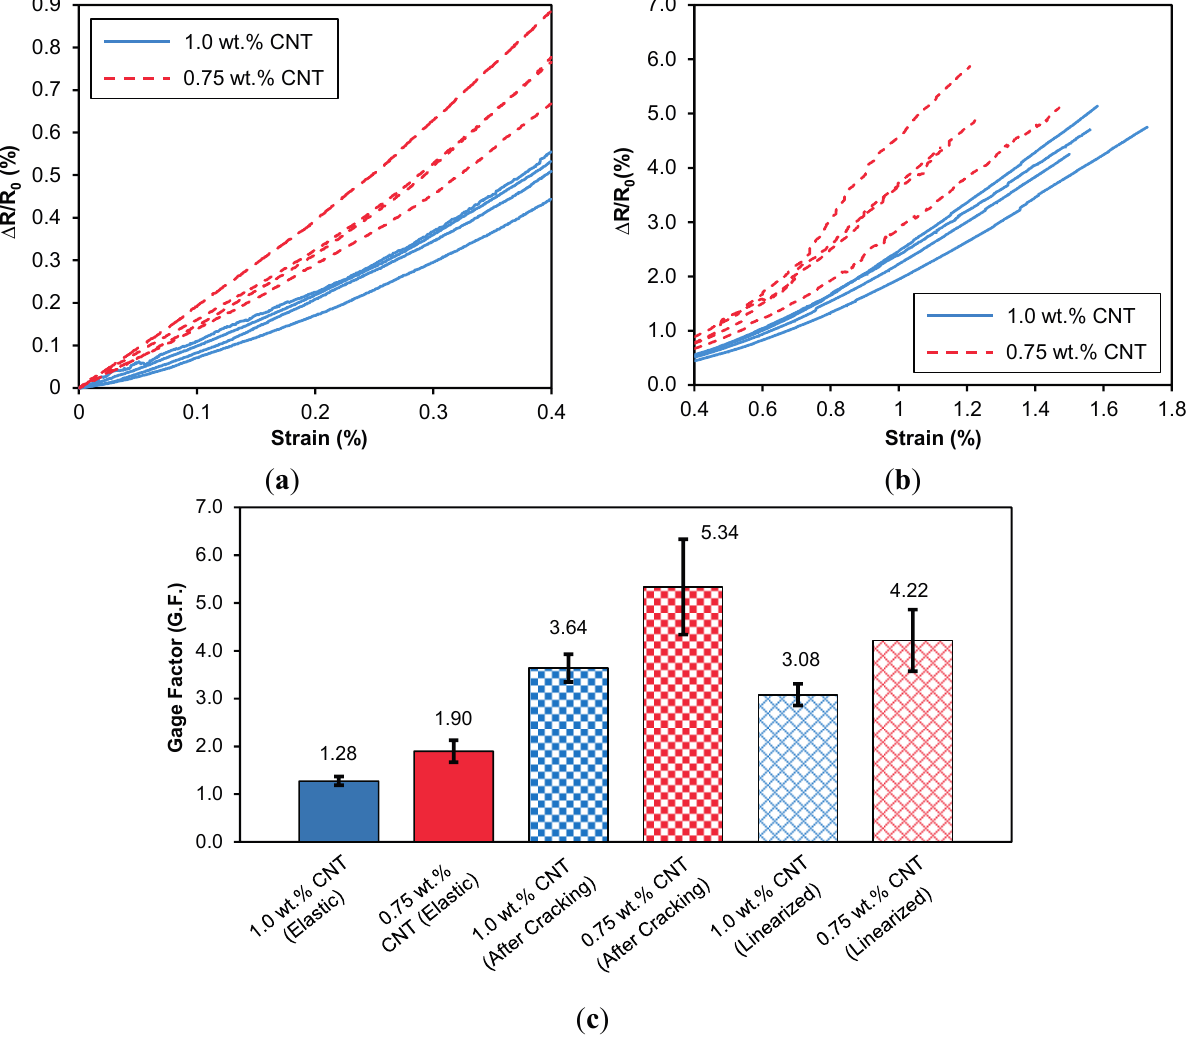
Figure 9. ( a ) Elastic and ( b ) inelastic piezoresistive responses from individual test coupons and ( c ) gage factors for the CNT-based nonwoven composite sensors fabricated in this research (error bars represent one standard